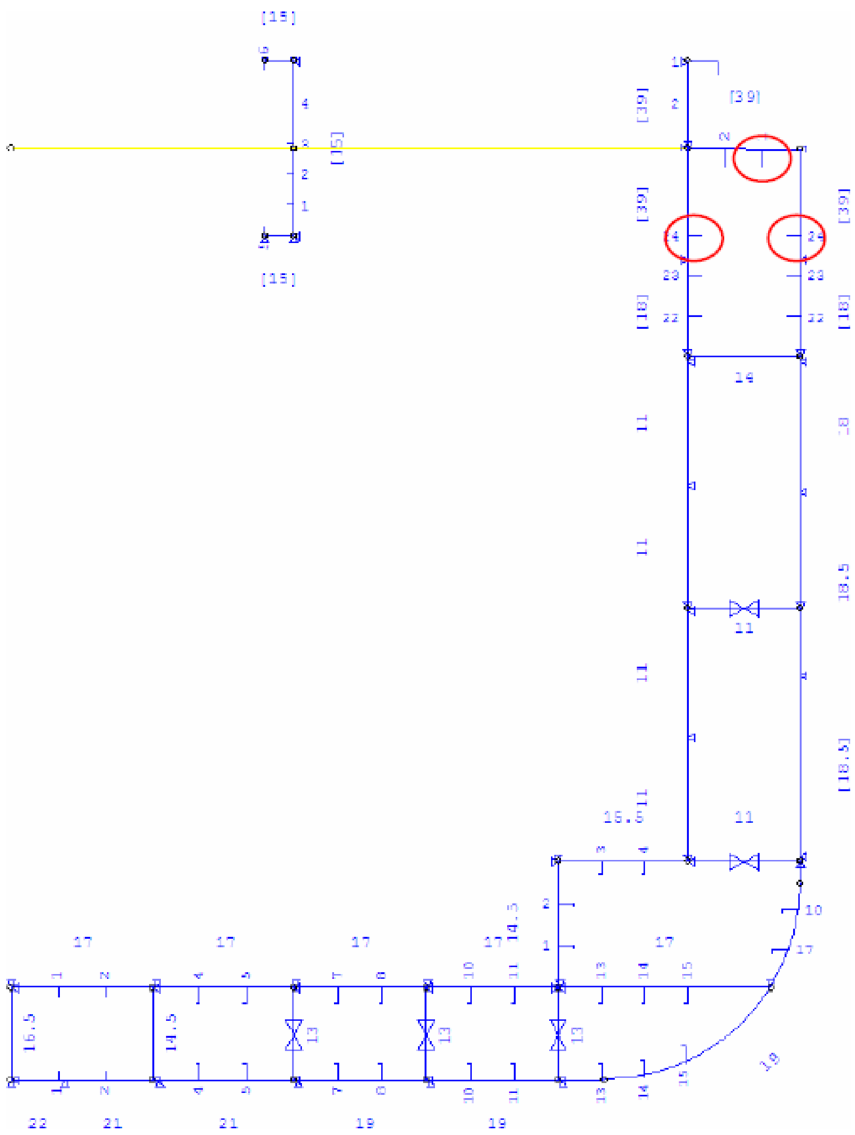
Figure 2. Layout of the mid-ship cross-section with measurement position in the upper deck and crack